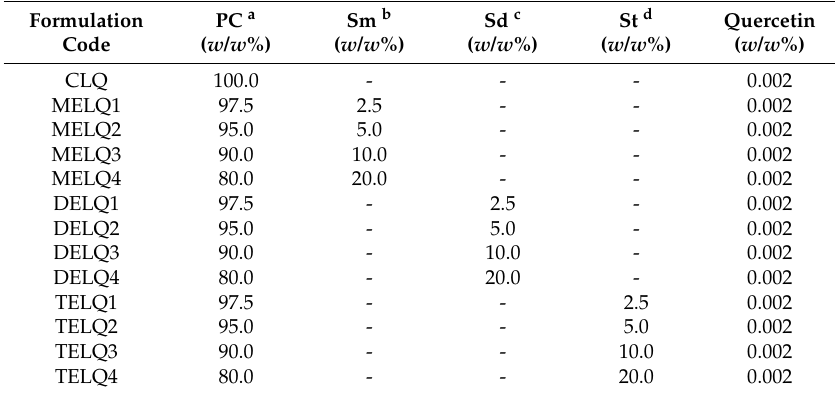
Table 1. Composition of various nanoliposomes containing